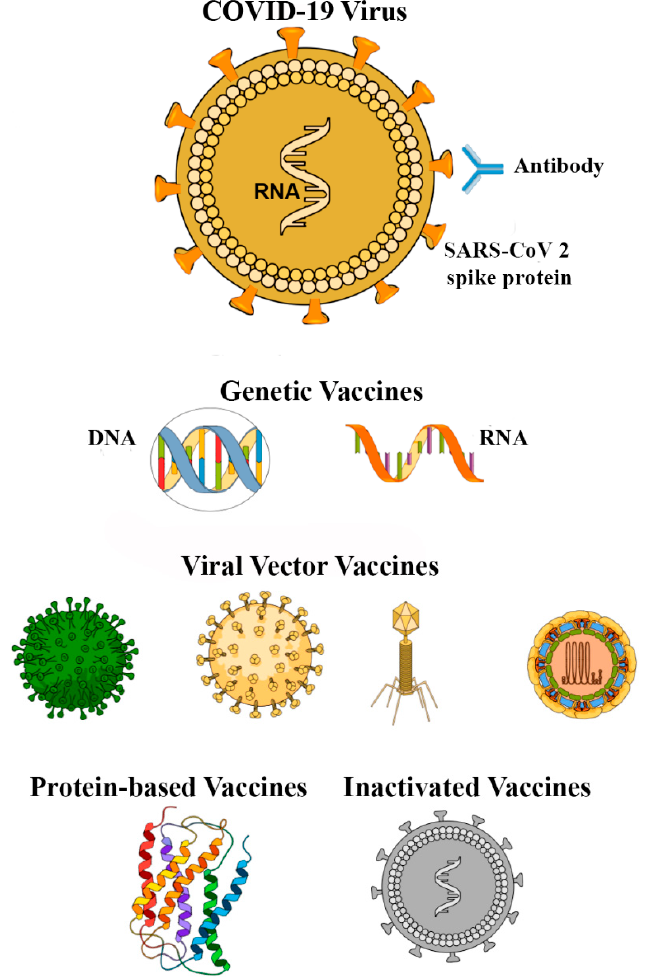
Figure 13. Different design strategies for new vaccine candidates based on nucleic acids such as DNA or RNA, viral vectors of different origins, peptide sequences or the antigen of the inactivated COVID virus.